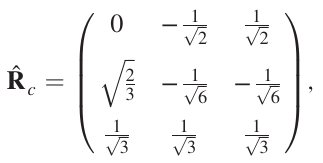
2160-3308 = 22 = 12(1) = 019902(2)